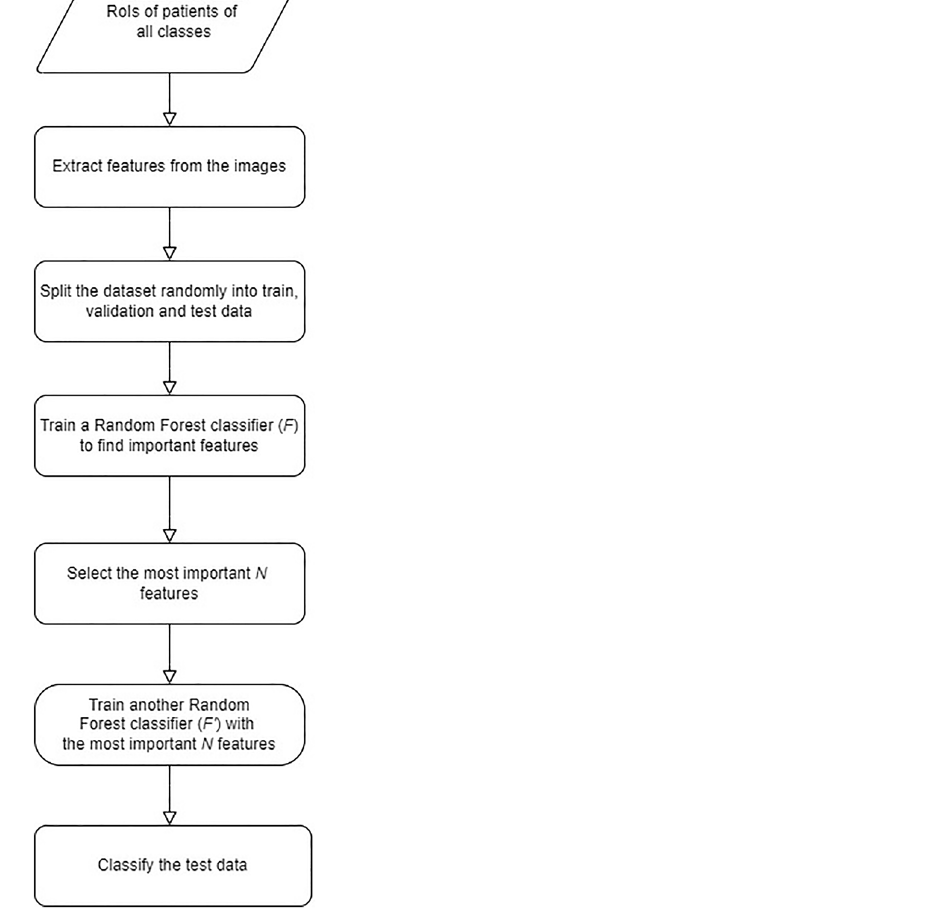
Figure 2. Flowchart showing the experimental steps of the proposed